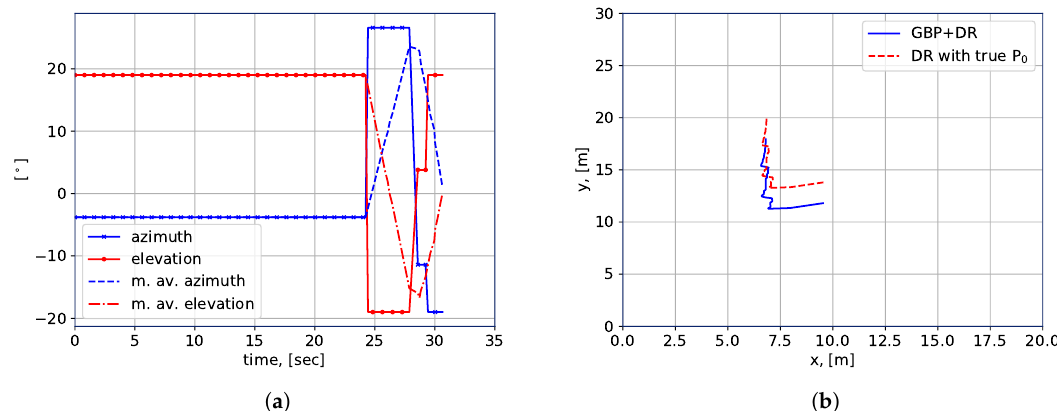
Figure 9. Practical implementation of location estimation algorithm, ( a ) WiGig beamforming variation; ( b ) Estimated and measured